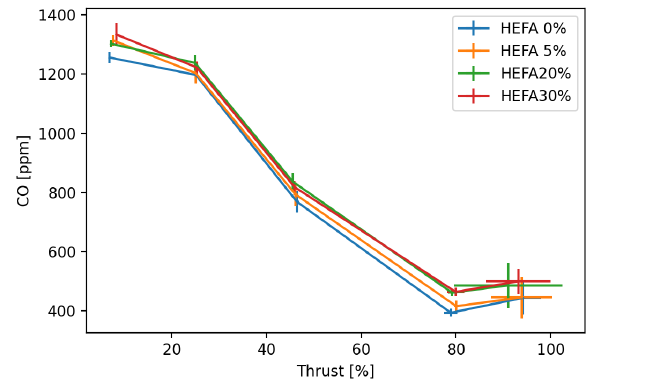
Figure 19. GTM-140/HEFA: CO